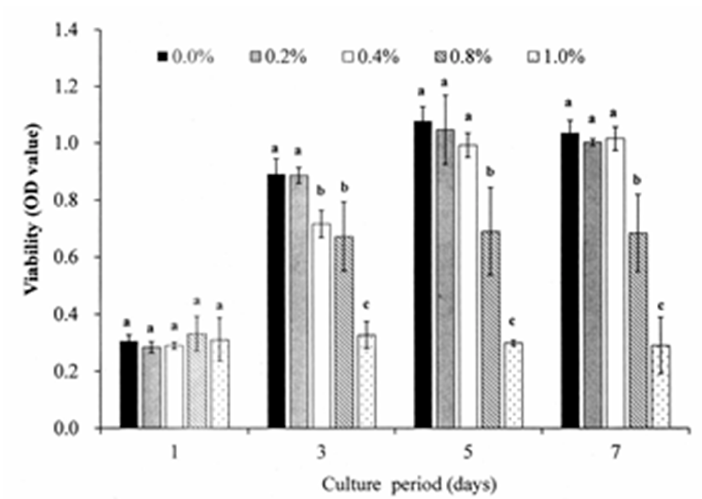
Figure 2. Viabilities of DPSCs cultured with various DMSO concentrations for a maximum period of 7 days. A DMSO concentration of 0.2% has no significant effect on the DPSC viability irrespective of the incubation period. Note that OD values not sharing the same letter are significantly different ( p < 0.05).